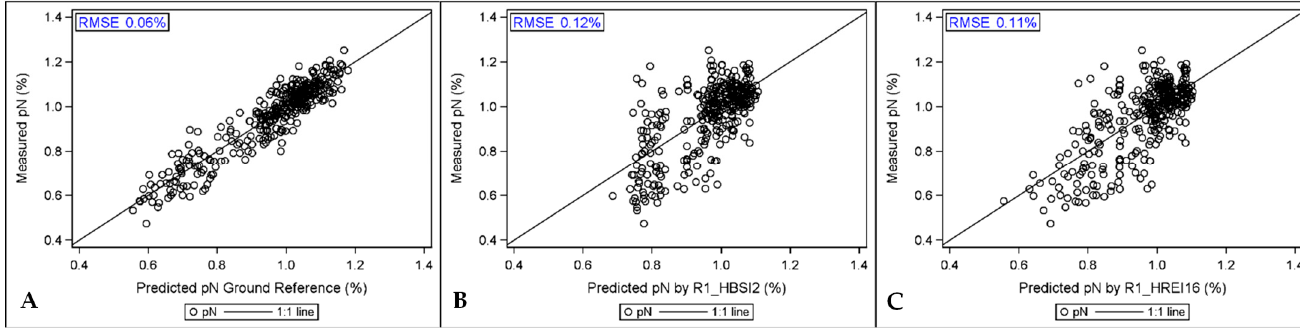
Figure 4. Predicted vs. actual (measured) estimates of N concentration (pN) (%) with RMSE for each plot. Black line is 45° reference line (1:1 line). ( A ) Ground reference mixed model; ( B ) R1 HBSI2; ( C ) R1 HREI16 models.